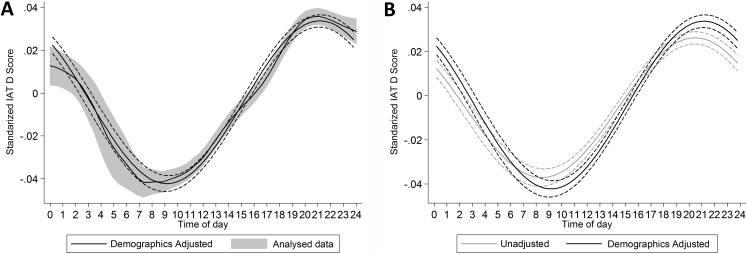
(A) presents the predicted cosinor function (±95% CI) superimposed over the local polynomial fit of the raw data (±95% CI).Note, that where cosinor function takes into account time as if it was circular, the local polynomial does not, which could lead to some distortion at the ends of the function. (B) comparison of the unadjusted and adjusted cosinor functions.